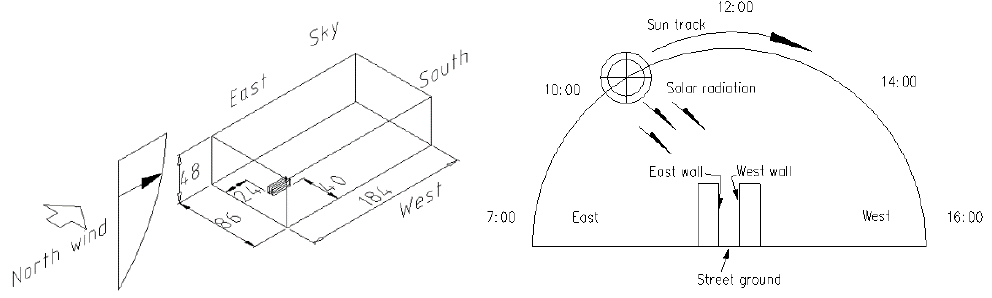
Figure 13. Schematic diagram of flow field and sun altitude angle.